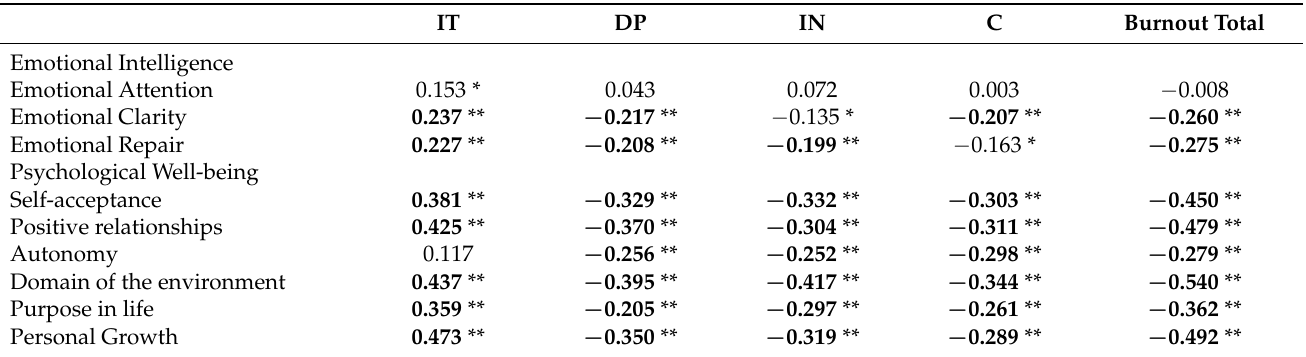
Table 3. Relationship of emotional intelligence and psychological well-being and burnout in active teachers. IT DP IN C Burnout